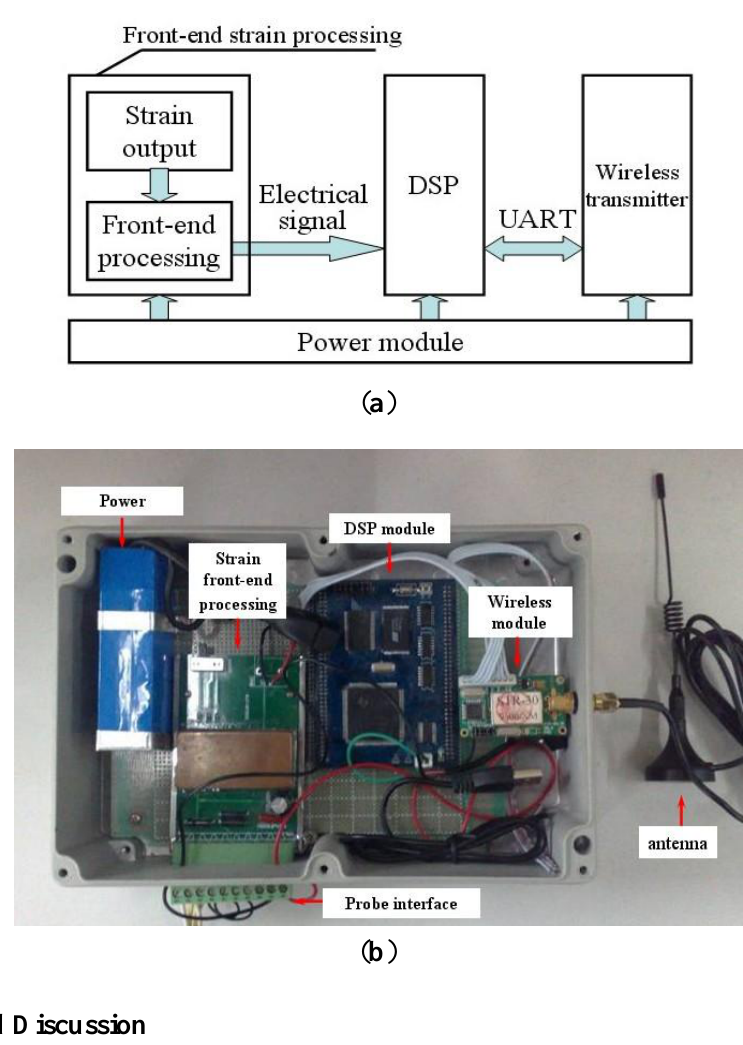
Figure 4. ( a ) The installation of hardware integration; ( b ) Photo of the